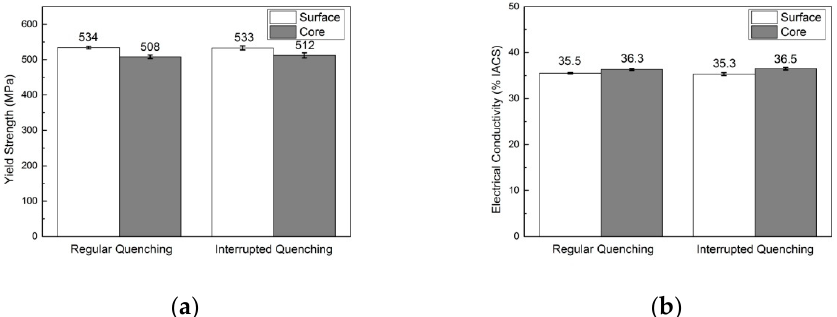
Figure 8. ( a ) Yield strength and ( b ) electrical conductivity of regular quenching and interrupted quenching after T74 aging treatment.